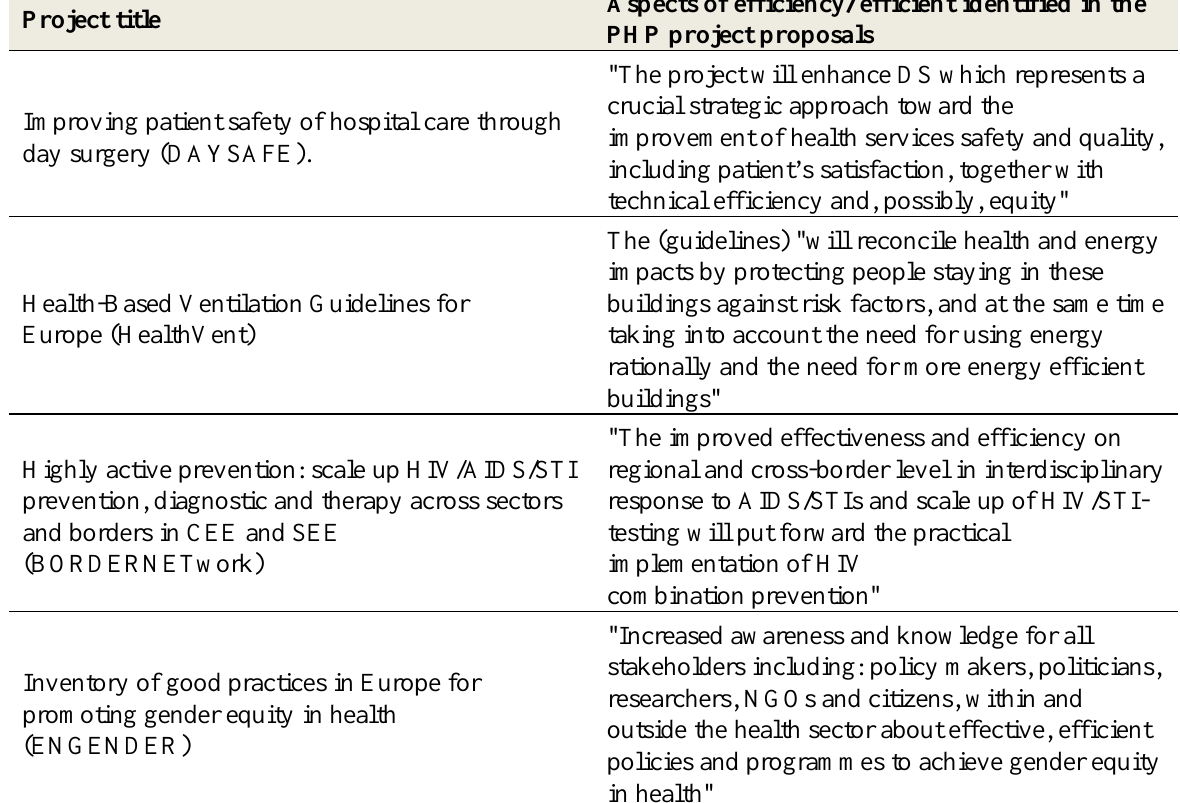
Table 4. Efficiency aspects identified in project